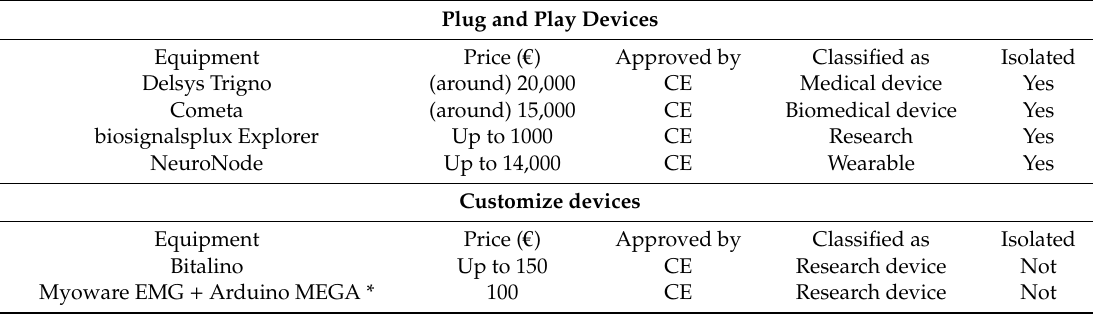
Table 2. Comparison between di ff erent commercial systems and the custom low-cost system and its technical data (Approved by: product is safe according to the applicable directives (CE “ Conformit é Europ é enne ”). Classified as: product was designed to be used as ... Isolated: if the product has internal electrical isolation, answer is “Yes”; but if the product needs external isolation, answer is “No”).